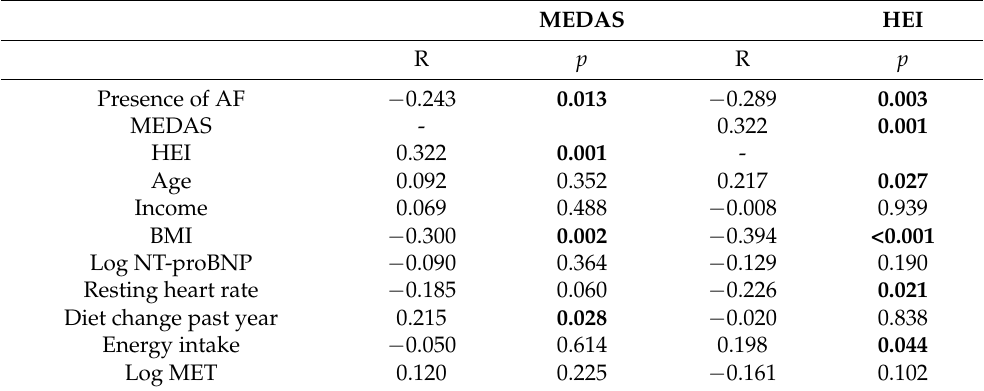
Table 2. Correlations of Mediterranean Diet Adherence Screener (MEDAS) and Healthy Eating Index (HEI) with independent variables.